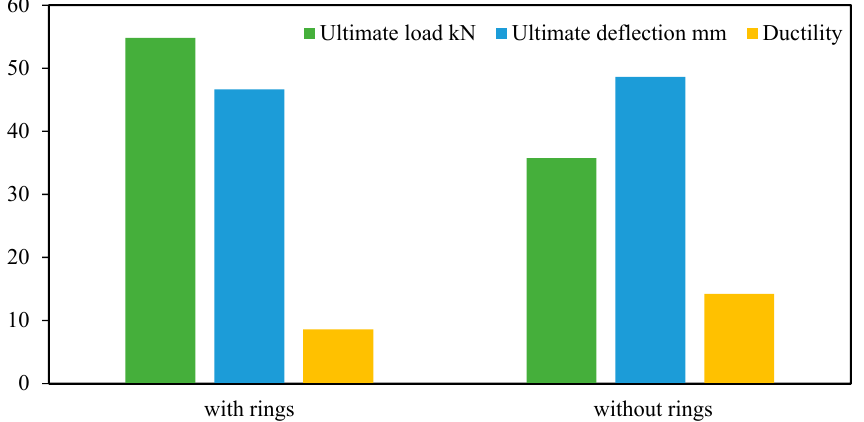
Figure 15. Results of the second group specimens in parametric case studies.